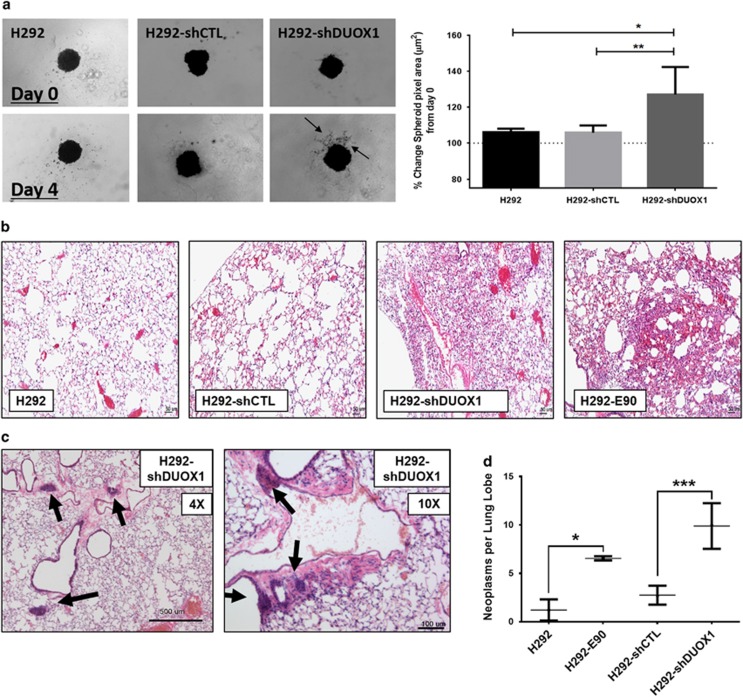
DUOX1 silencing displays enhanced invasive properties. (a) H292-shDUOX1 cell spheroids display invasion into surrounding extracellular matrix (ECM)-like matrix after 4 days, arrows display cellular invasion into mock ECM gel matrix. Right panel shows average percent change in pixel area quantified over the course of multiple experiments. *P<0.05, **P<0.01. (b) H&E-stained lung sections of H292-shDUOX1- or H292-E90-injected mice present significantly altered lung architecture. (c) Localized areas of neoplasias or small engrafted tumors in H292-shDUOX1-injected mouse lungs. (d) Quantification of counted lung neoplasias >120 μM in diameter for animals injected with various cell models. *P<0.05 and ***P<0.001 were calculated by Student's t-test.